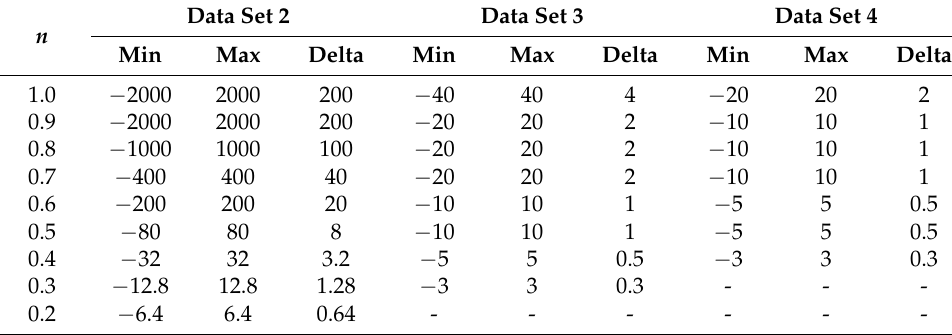
Table 4. The ranges of variation for Π δ p , x for Data Sets 2 to 4. Data Set n